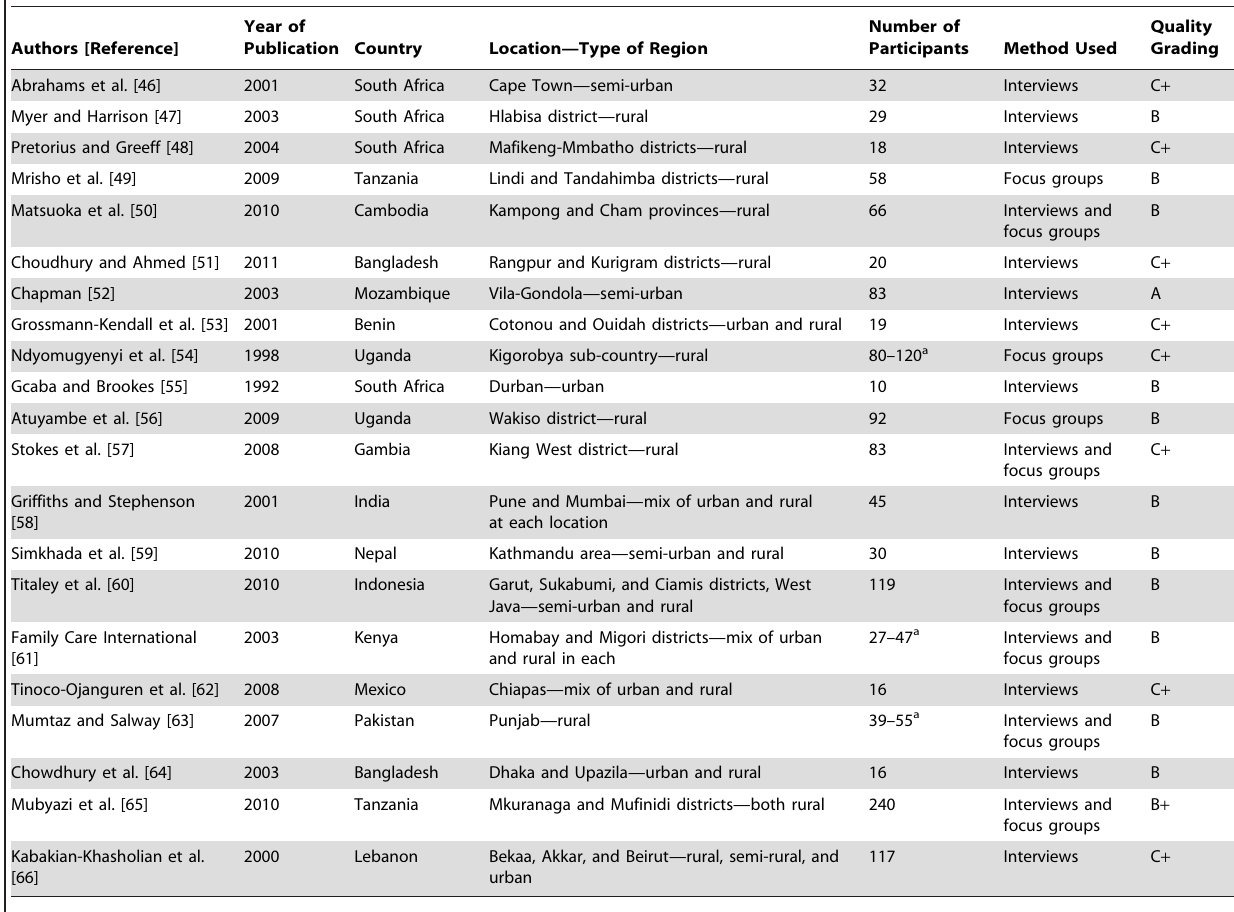
Table 1. Summary of included